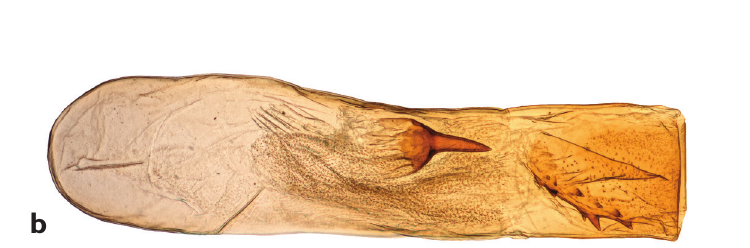
Figure 22. Genitalia of Abagrotis crumbi benjamini (Paratype). USNM dissection #36838. a Clasper b